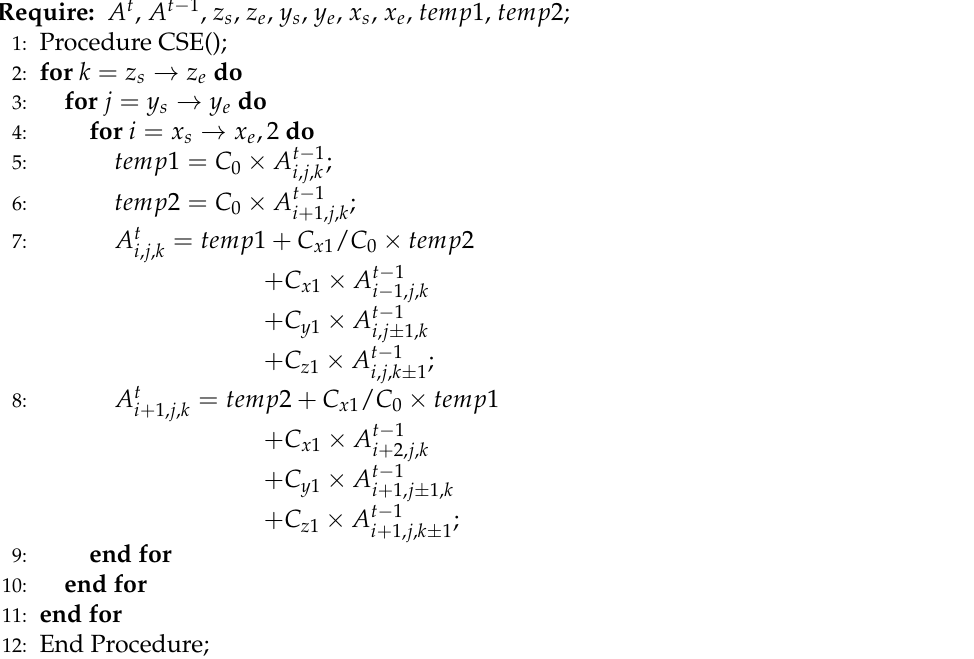
Figure 3. Code example sub-expression elimination principle. Algorithm 6 Stencil computation with the principle of sub-expression